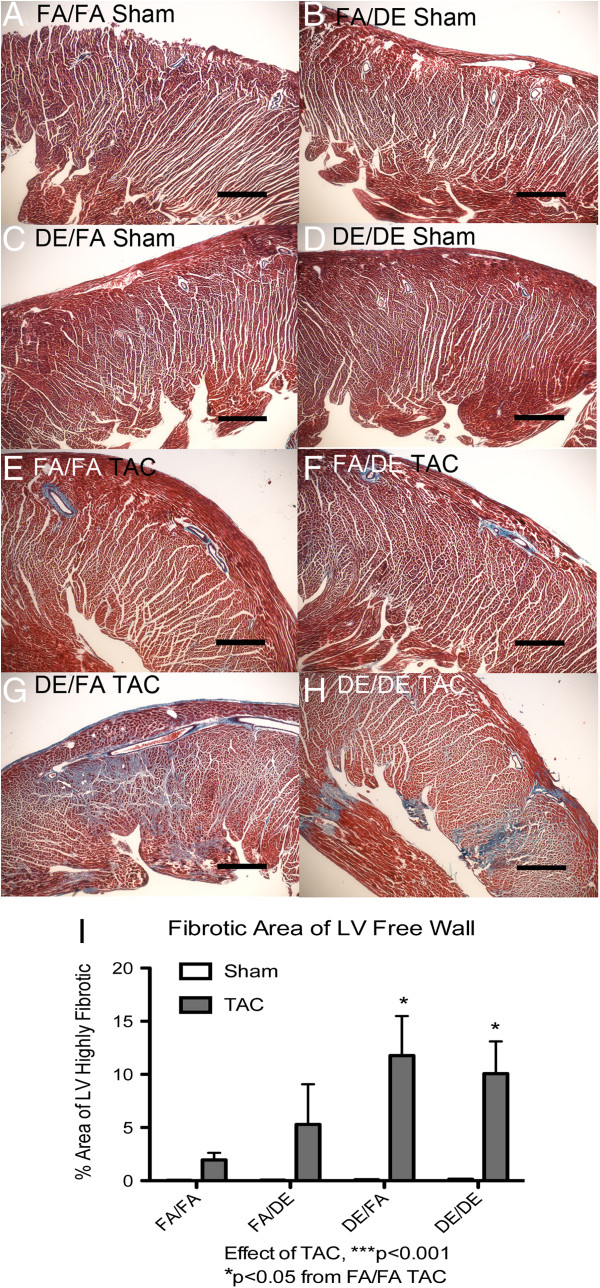
Assessment of cardiac fibrosis by Masson’s Trichrome staining. Representative images (4X objective) of sagittal sections of left ventricle free wall from mice three weeks post sham or transverse aortic constriction (TAC) surgeries (A-H), scale bar = 0.5 mm. Fibrotic regions of cardiac tissues are determined by blue staining in FA/FA (n = 5 sham, n = 5 TAC), FA/DE (n = 3 sham, n = 3 TAC), DE/FA (n = 5 sham, n = 5 TAC) and DE/DE (n = 5 sham, n = 4 TAC) groups. Assessment of percentage highly fibrotic regions was quantified (I).